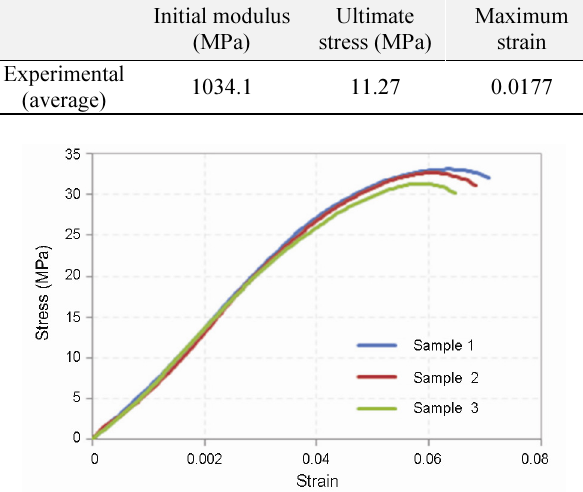
Fig. 4. Experimental compressive stress–strain relationships of WPC samples